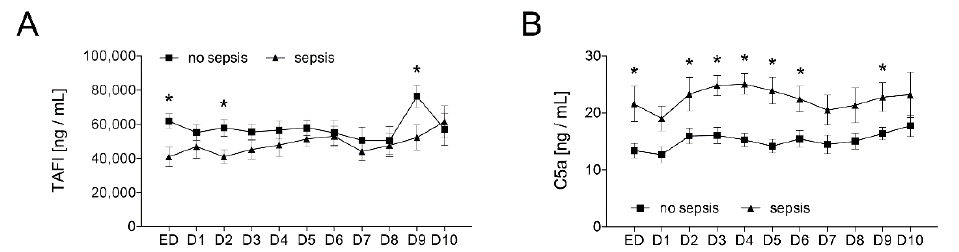
Figure 5. Upon admission of severely injured trauma patients ( n = 48) to the emergency department (ED), plasma TAFI levels ( A ) and plasma C5a levels ( B ) were determined daily for ten days (D1–D10). Patients were stratified to those who developed sepsis in their clinical course (sepsis, n = 14) vs. those who did not develop infectious complications (no sepsis, n = 34). Data are shown as mean ± SEM. * p < 0.05 sepsis vs. no sepsis at the indicated time.